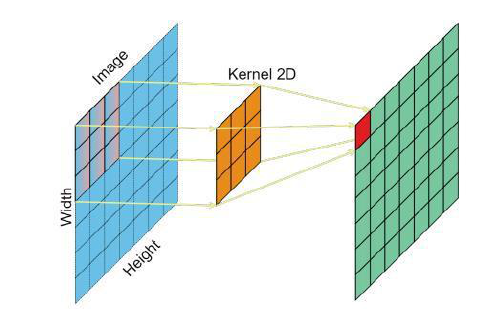
Figure 4. Example of a 2D convolution. The goal is for the network to learn the weights of the convolution kernel (in